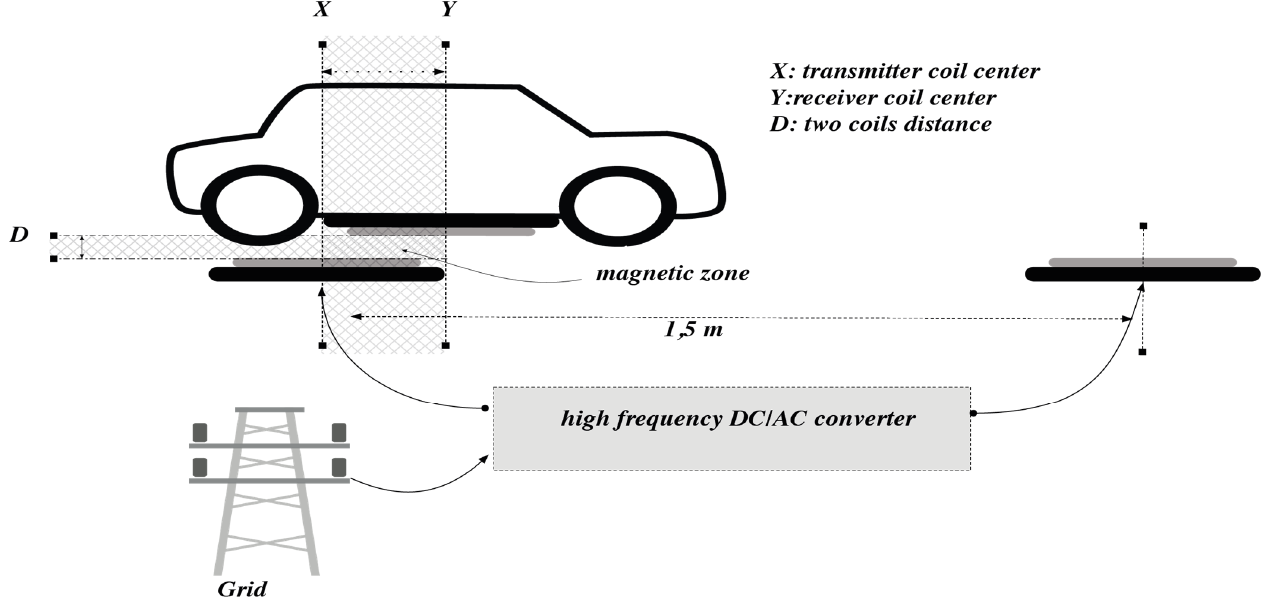
Figure 3. Structure of the inductive power transfer system.